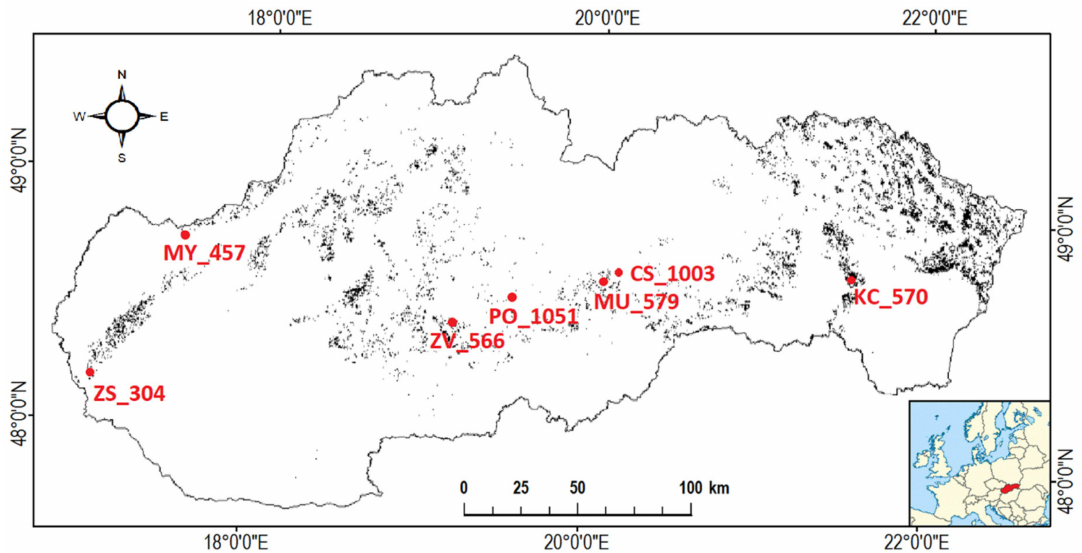
Figure 1. Seven phenological stations of Slovak Hydrometeorological Institute (SHMI) with beech forests: numerical values in each of the seven locations mark the altitude. Black colour on the map marks forests where European beech dominates ( > 60%) in the forest tree species